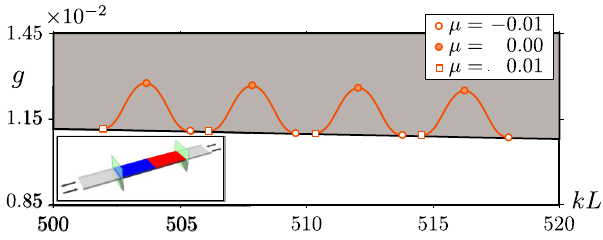
FIG. 6. CPA laser points for a PT -symmetric scatterer con- sisting of two adjacent regions of refractive index n ¼ 1 : 5 (cid:7) ig , with zero-width mirrors at the scattering boundary (see the bottom left inset). The mirror parameter (cid:4) is defined in Eq. (B1). The orange curves show the trajectories of four distinct CPA laser points for varying values of (cid:4) , with the symbols indicating the positions at particular values of (cid:4) (see the top right inset). The solid black curve is the exceptional